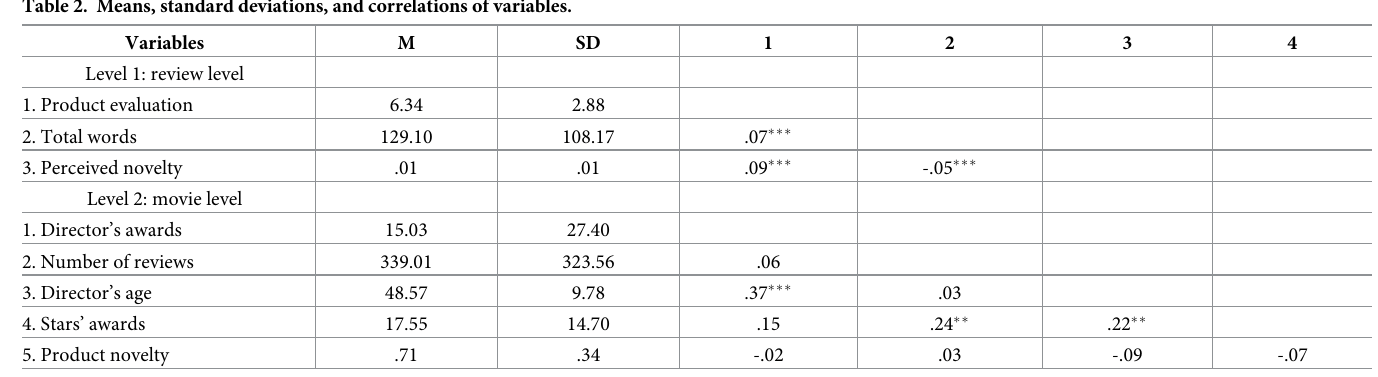
Table 2. Means, standard deviations, and correlations of